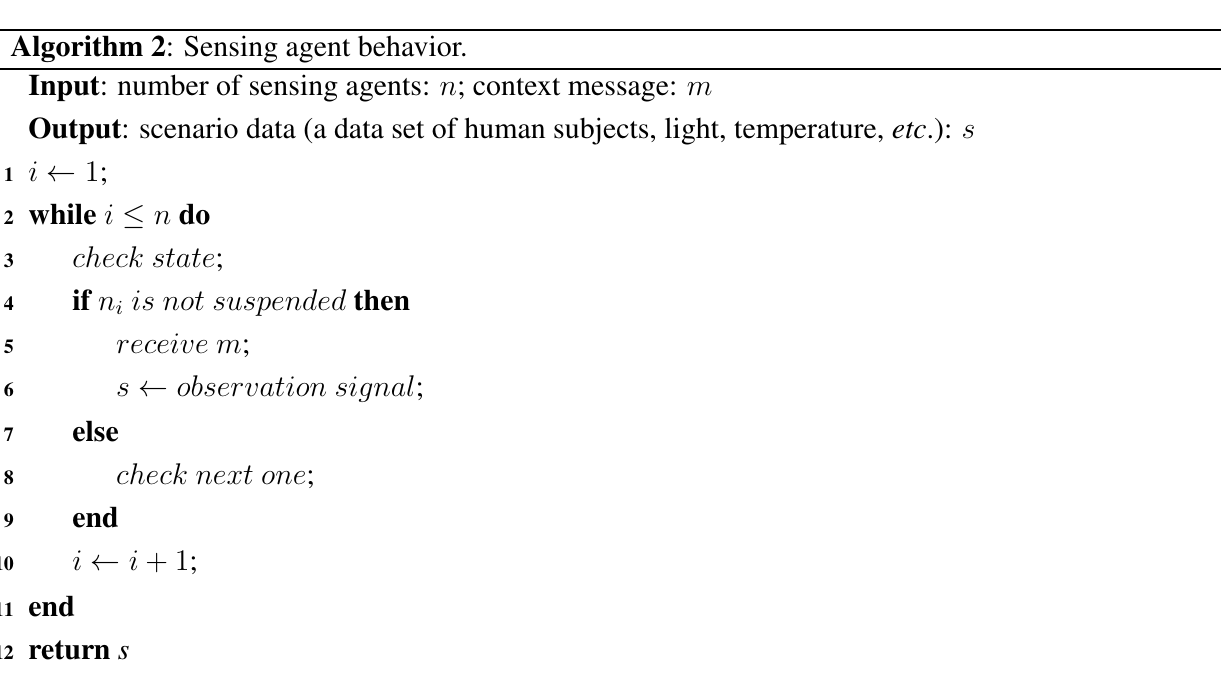
Algorithm 2 : Sensing agent